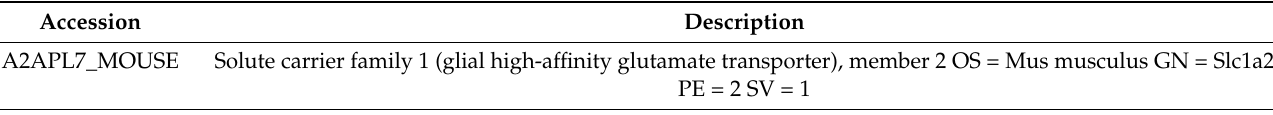
Table 5. Effects of feeding with matcha and decaffeinated matcha on the expression of proteins involved in glutamate transport and metabolism and in GABA formation and